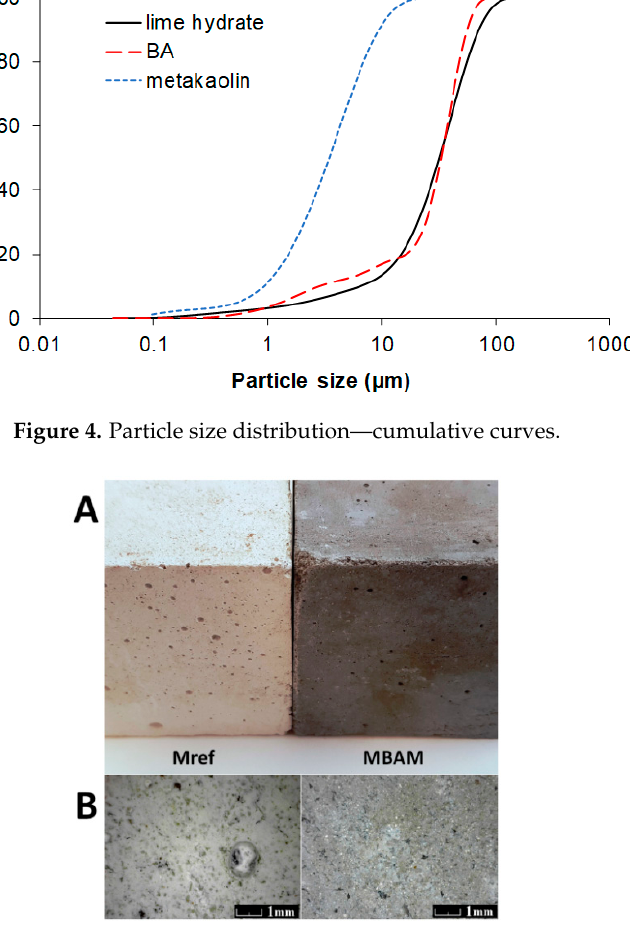
Figure 5 . ( A ) Photography of M ref ( left ) and MBAM ( right ) and ( B ) optical micrograph of M ref ( left ) and MBMA ( right ) .